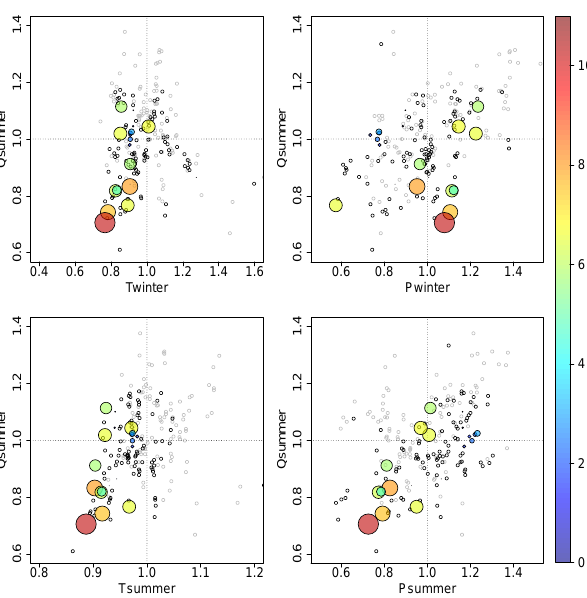
Figure A3. Glaciermelt drought events in Austrian catchments Figure 14. Glaciermelt drought events in Austrian catchments based on simulated discharge: stan- based on simulated discharge: standardised summer discharge dardised summer discharge ( Q summer ) [–] against standardised causing factors ( T winter , P winter , ( Q summer ) (–) against standardised causing factors ( T winter , P winter , T summer , P summer ) [–]. Below 1 = below average, above 1 = above average. Grey circles: all years, T summer , P summer ) (–). Below 1 = below average; above 1 = above black circles: all drought years, coloured circles: glaciermelt drought years (size and colour of dots average. Grey circles: all years; black circles: all drought years; is dependent on standardised drought deficit [–], scale on right side of figure). NOTE: selection of coloured circles: glaciermelt drought years (size and colour of dots (snowmelt) drought years and size and colour of dots is based on observed discharge. are dependent on standardised drought deficit (–); scale on the right side of the figure). Note: selection of (snowmelt) drought years and 57 size and colour of dots is based on observed discharge.